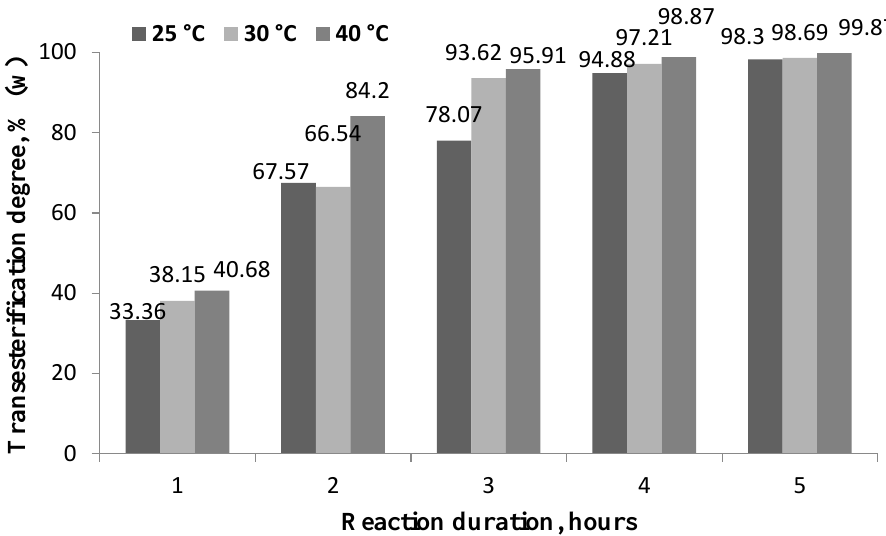
Figure 3. Dependence of transesterification degree on the reaction temperature and duration at a molar ratio of RO to butanol of 1:5 and a lipase concentration of 7%.